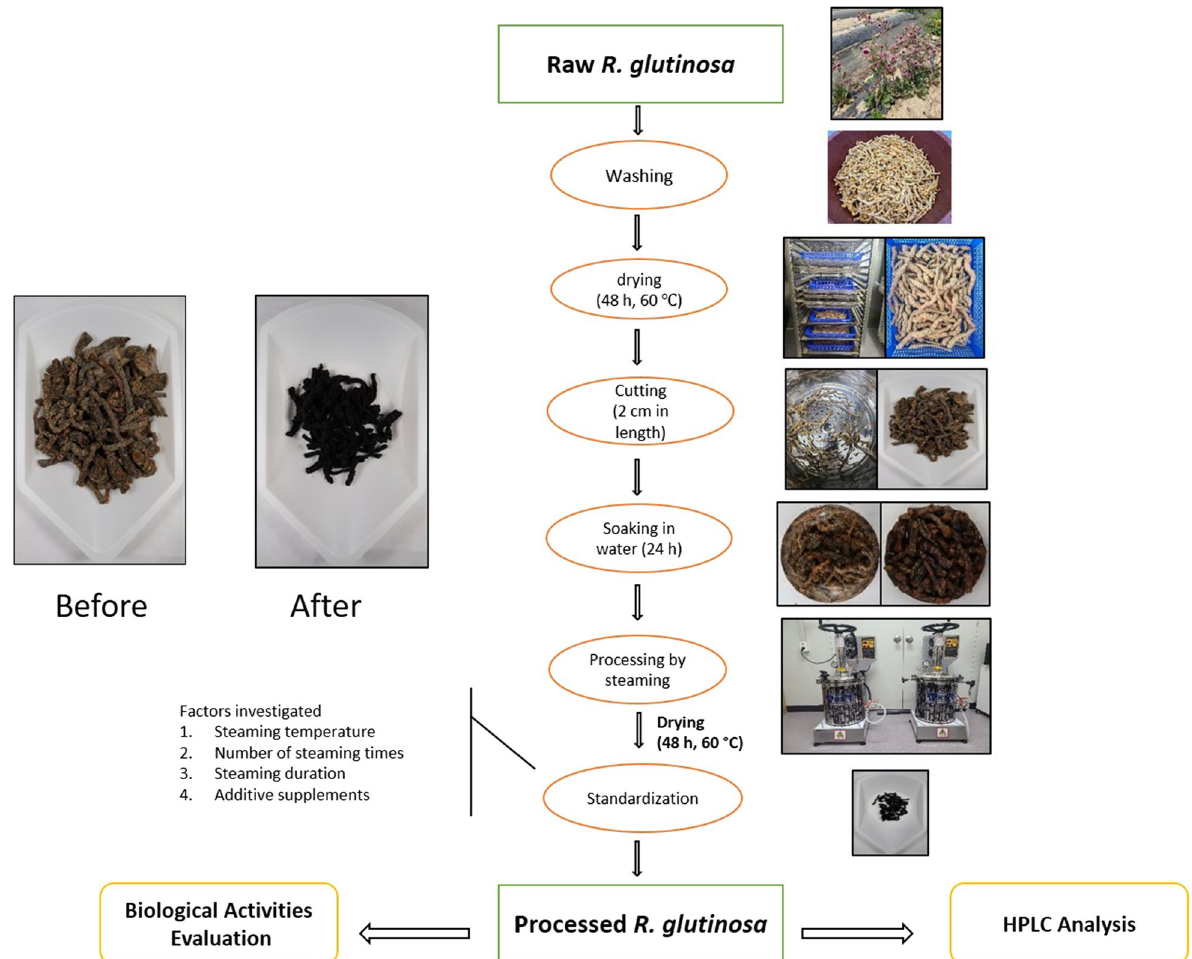
Fig. 1 The overall schematic diagram of R. glutinosa processing method by steaming